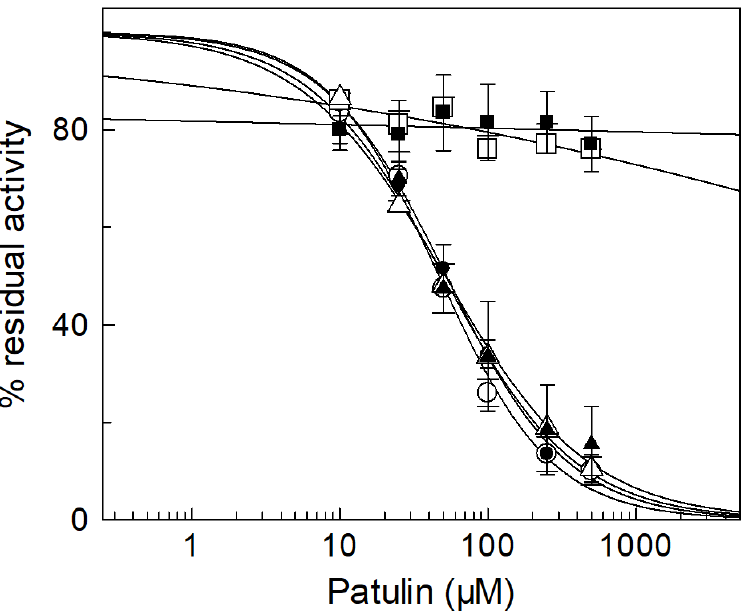
Figure 2. Dose-response analysis of the PAT inhibition of the CAC recombinant proteins. Transport activ- ity of the reconstituted rat ( ○ ) and human ( ● ) WT, C136S ( □ ), C23V/C58V/C89S/C136V/C283S ( ■ ), C155S ( Δ ) and C23V/C58V/C89S/C155V/C283S ( ▲ ) was measured by adding 0.1 mM [ 3 H]-carnitine after PAT treatment at the indicated concentrations for 30 min. The data are expressed as a per- centage of the controls (no PAT addition) and are means ± SD of three independent experiments.